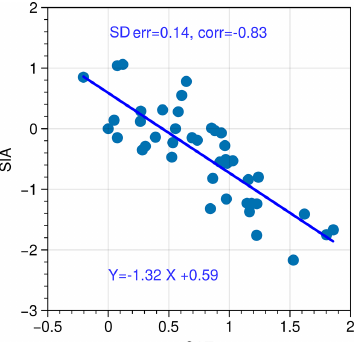
Figure A6. Scatterplot of SAT versus SIA for current